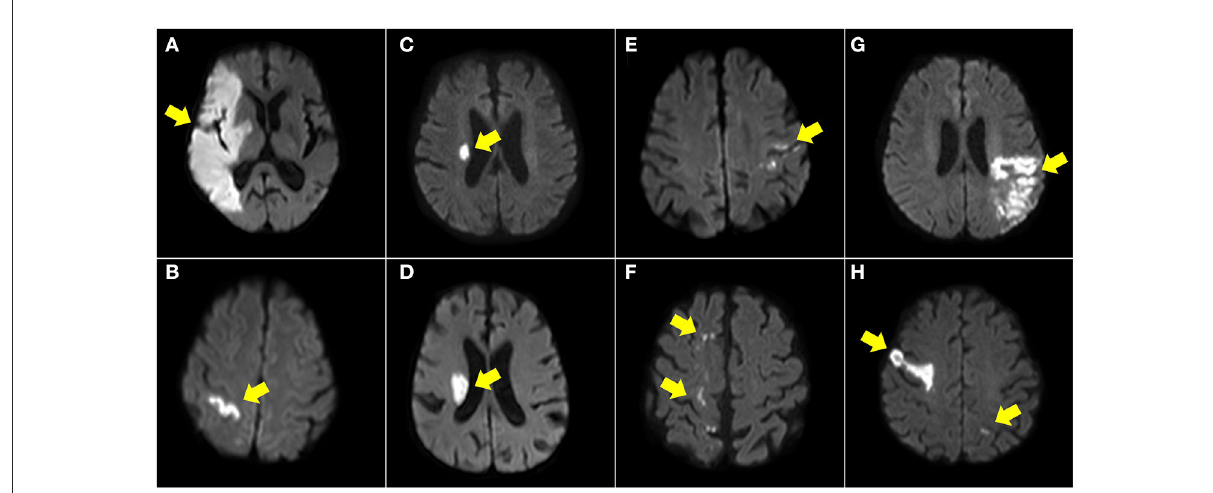
FIGURE2 Illustration of DWI patterns in anterior circulation. Territory infarct (A) , single cortical infarct (B) , single subcortical infarct ( < 20mm) (C) , single subcortical infarct ( > 20mm) (D) , small scattered cortical or subcortical infarcts (E) , border zone infarcts (F) , other cortical and subcortical infarcts (G) , and multiple territories (H)